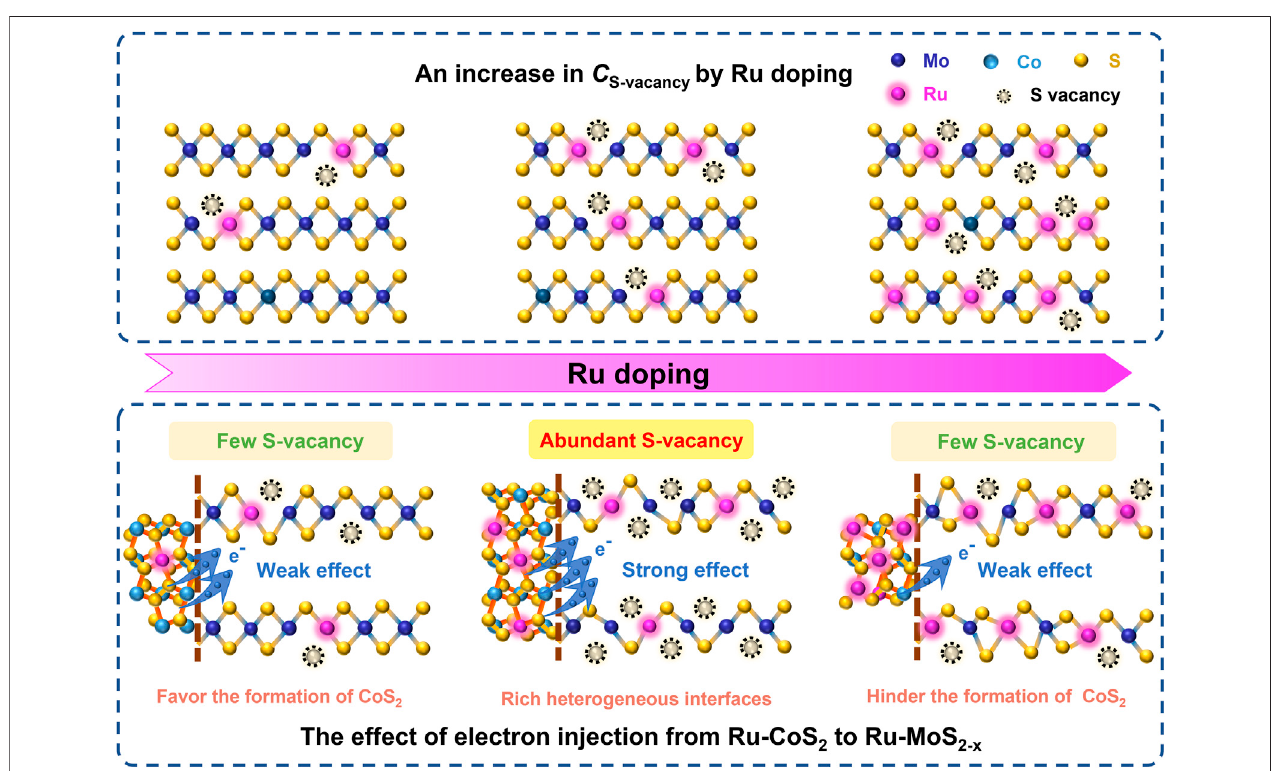
FIGURE 5 | Schematic illustration of the possible formation mechanism of the S-vacancy of the basal planes in Ru-MoS 2-x of Ru-MoS 2-x -CoS 2 /CC samples.